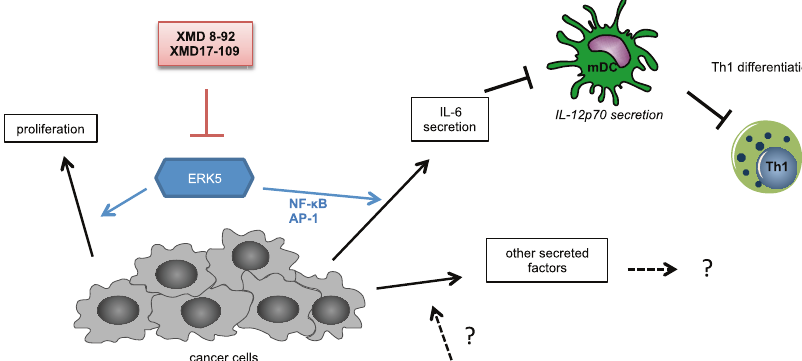
Fig. 7 ERK5 inhibitors impair cancer cell viability and inhibit IL-6 secretion. Schematic illustration of how XMD 8-92 affects a subset of cancer cells. In brief, ERK5 modulates IL-6 secretion of cancer cells and thereby also tumor-induced immune suppression since IL-6 secreted by cancer cells impairs IL-12p70 secretion of moDCs that in turn negatively affects Th1 differentiation. NCI-H226 on the activity of the aforementioned transcription protein-1) consensus site [62, 63], a cAMP response element (CRE) factors by employing a fi lter plate assay (Supplementary Fig. 8). [64], a nuclear factor (NF)-IL6 binding site [65, 66] and an NF- κ B- Here, we observed that in ERK5-knockdown cells the activity of responsive element [67] (Supplementary Fig. 8). In fact, we have AP-1 was slightly impaired, while the negative impact on NF- κ B tested the in fl uence of a siRNA-mediated knockdown of ERK5 in Cell Death and Disease (2021)